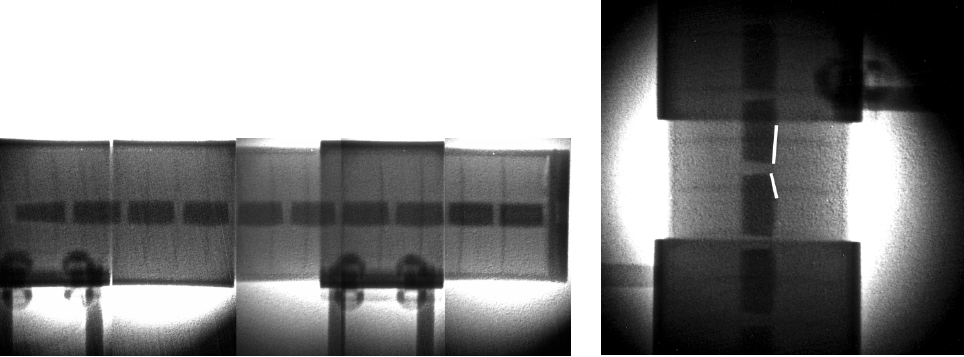
Figure 11. Radiograph of the HiRadMat-42 target assembly. The sliced tantalum cores appear bent due to permanent plastic deformation induced by the proton beam impacts, as also confirmed by the neutron tomography at the NEUTRA neutron beam line (PSI)